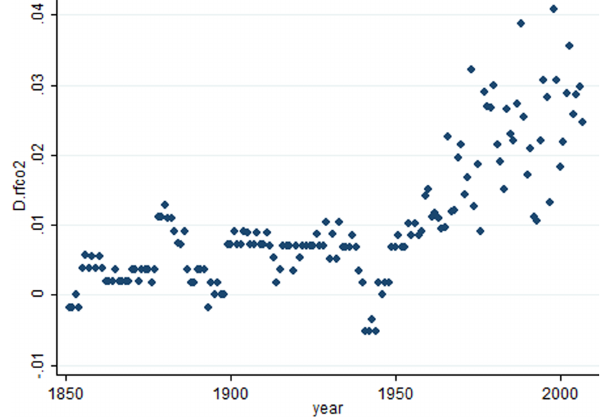
Fig. 2. Time series of the first differences of rfCO 2